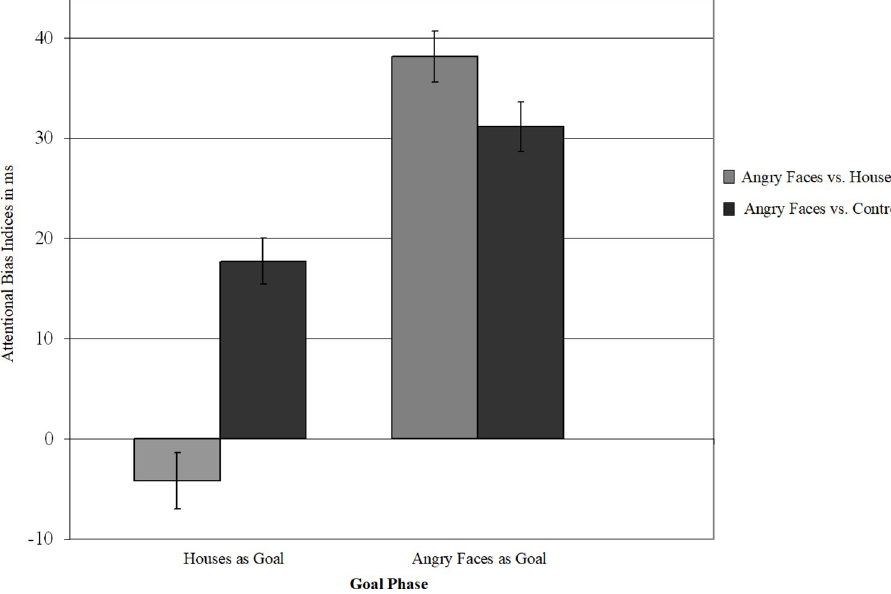
Fig 2. Attentional bias indices for the two trial types presenting angry faces. Angry faces were presented in comparison to houses or control car stimuli in house goal and angry face goal phases. Positive attentional bias indices indicate attention towards angry faces, negative attentional bias indices attention towards houses or control car stimuli. Error bars represent standard errors of mean.